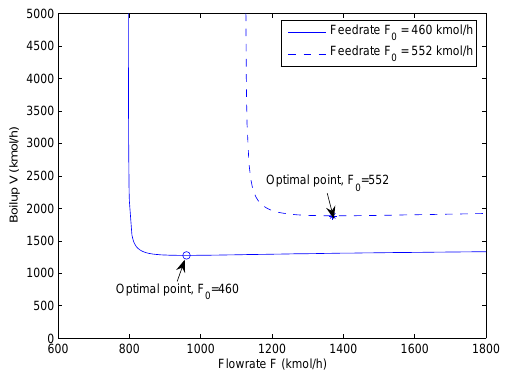
Figure 3: Boilup V as a function of column feed F , for nominal and maximal external feed F 0